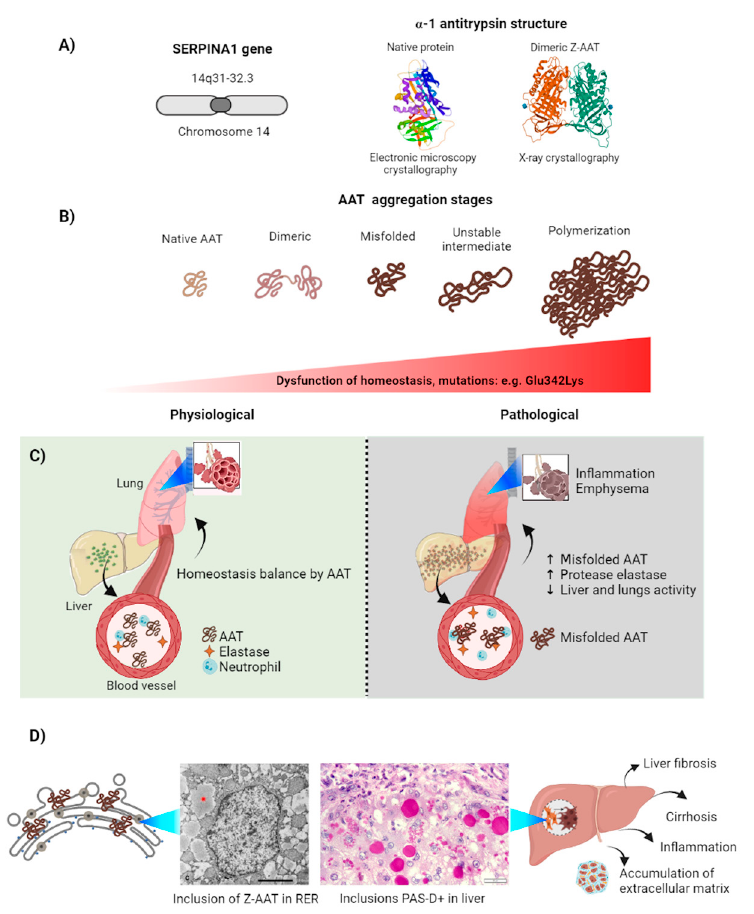
Figure 2. Z-AAT misfolding and aggregation in AAT Deficiency. ( A ) Left: Serpin-1 gene coding for AAT on chromosome 14 [99]; Right: Structural detail of native (PDB 3NE4) and dimeric Z-AAT (PDB 5IO1) structures obtained by crystallography. ( B ) Aggregation states of AAT. ( C ) AAT activity under physiological conditions (left) and in alterations to its function (right). ( D ) Left: Z-AAT aggregates in the ER in a liver sample from a patient with AATD. Next, an image taken by electronic microscopy (15,725×) showing a hepatocyte whose rough ER shows dilated cisternae with accumulated AAT. Image taken from Callea et al. (2021) [100]. Right: Liver tissue section with hepatocytes containing periodic acid-Schiff with diastase (PAS-D) positive inclusions, distinctive of AAT accumulation. Scale = 20 µ m. Image taken from Callea et al. (2021) [100]. These affectations lead to the development of liver fibrosis, cirrhosis, prolonged inflammation, and extracellular matrix accumulation in liver and lungs